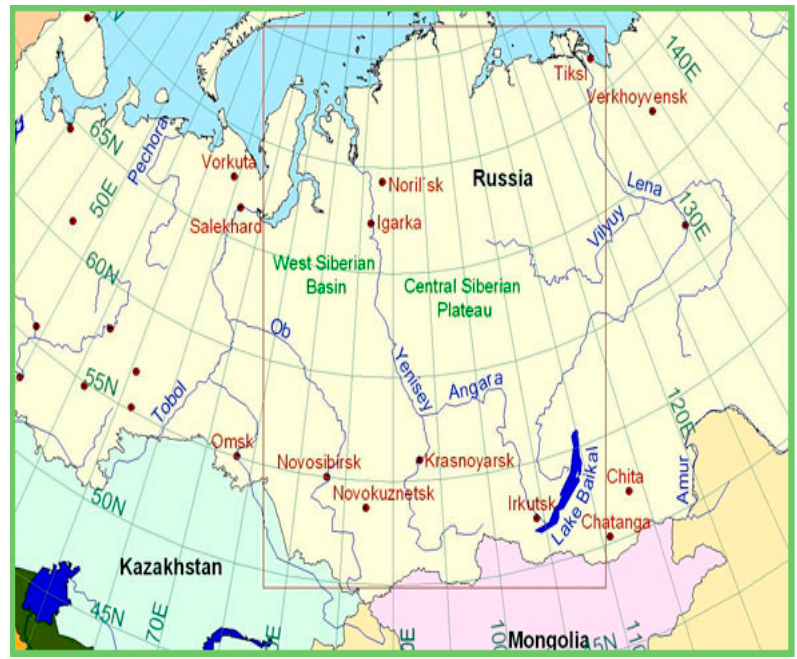
Figure 1. Location of the Angara/Yenisei River system in Central Siberia,